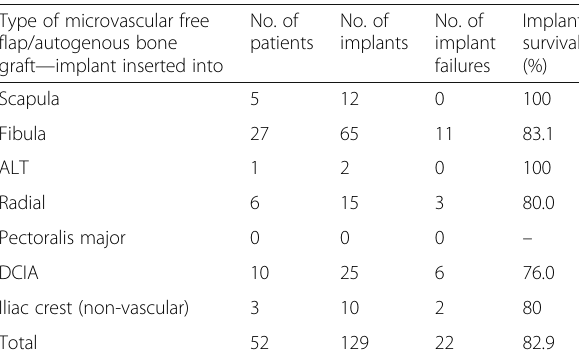
Table 8 Type of microvascular free flap/autogenous bone graft implant placed into and implant survival Type of microvascular free flap/autogenous bone graft — implant inserted into